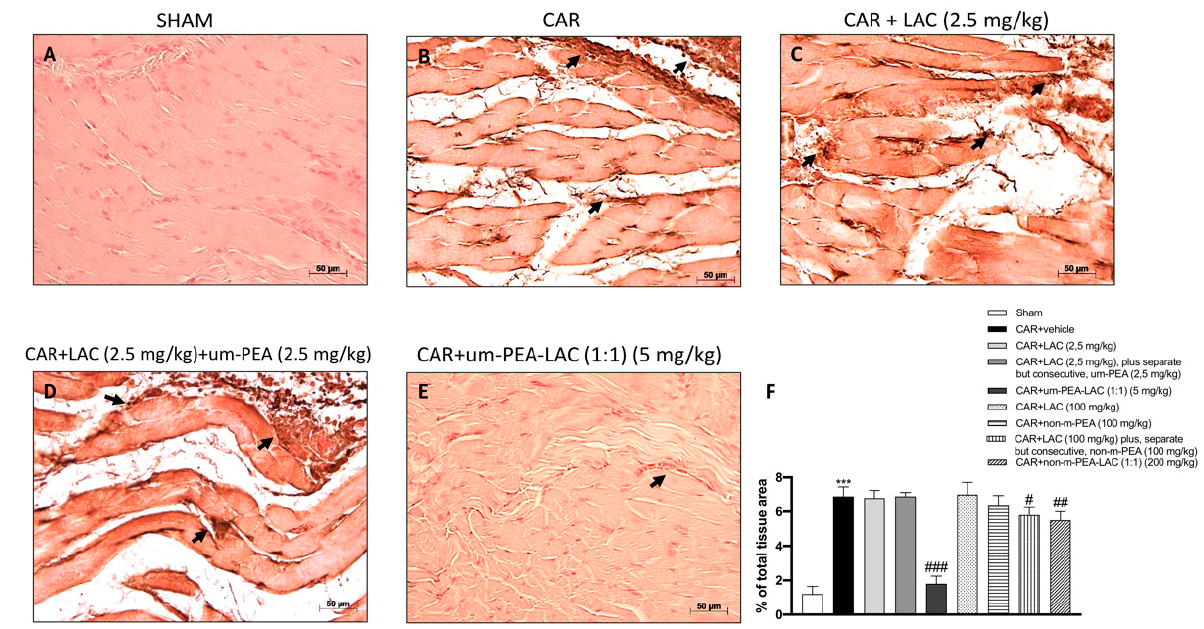
Figure 7. Efficacy of um-PEA and LAC treatment on COX-2 expression. Immunohistochemical analysis of COX-2 in the paw tissue from sham-treated rats ( A , F ) or from CAR-injected animals ( B , F ) are shown. The intensity of the COX-2 positive staining was markedly reduced in tissue section obtained from CAR-injected animals which have been treated with um-PEA and LAC (5 mg/kg) ( E , F ), and in a reduced way with CAR + LAC (100 mg/kg) plus, separate but consecutive, non-m-PEA (100 mg/kg) and CAR + non-m-PEA and LAC (1:1) (200 mg/kg) (data not shown). While other treatments did not show any down-regulation of COX-2 expression induced by CAR-injection ( C , D , F and data not shown). Black arrows indicate the positive staining for COX-2. Data are representative of at least three independent experiments. Values are means ± SEM. One-Way ANOVA test. *** p < 0.001 vs. sham; # p < 0.05 vs. CAR; ## p < 0.01 vs. CAR; ### p < 0.001 vs. CAR.